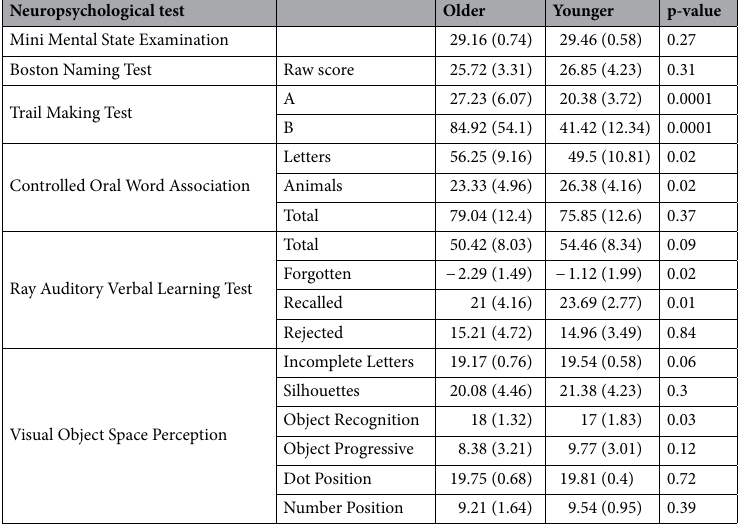
Table 1. Comparison of younger and older adults on a battery of neuropsychological tests spanning general cognition (MMSE), executive control (TMT), retrieval fluency (BNT, COWA), verbal working memory (RAVLT), and visuospatial abilities